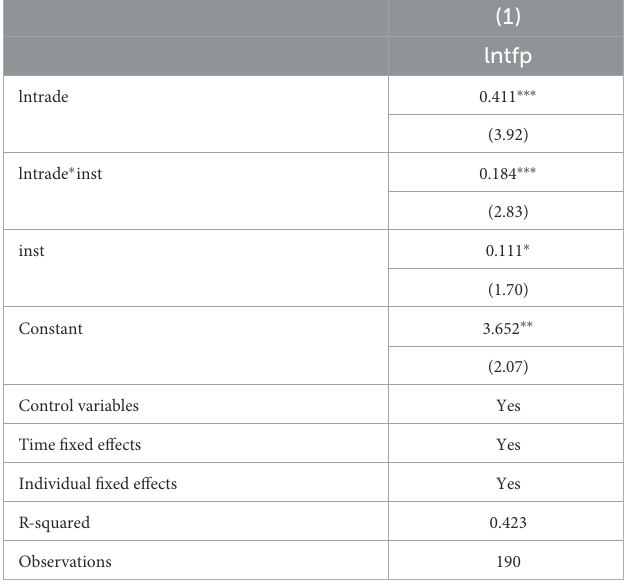
TABLE 8 Moderating effect of the institutional